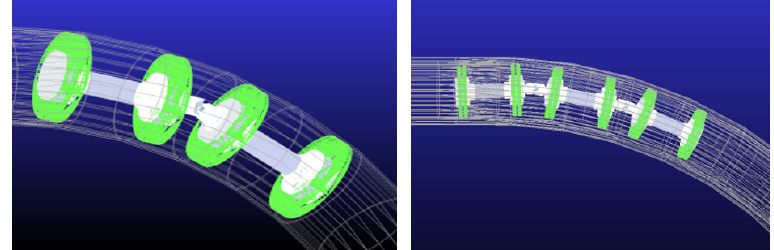
Figure 10 . Pipe robots with di ff erent numbers of sections. Figure 10. Pipe robots with different numbers of sections.